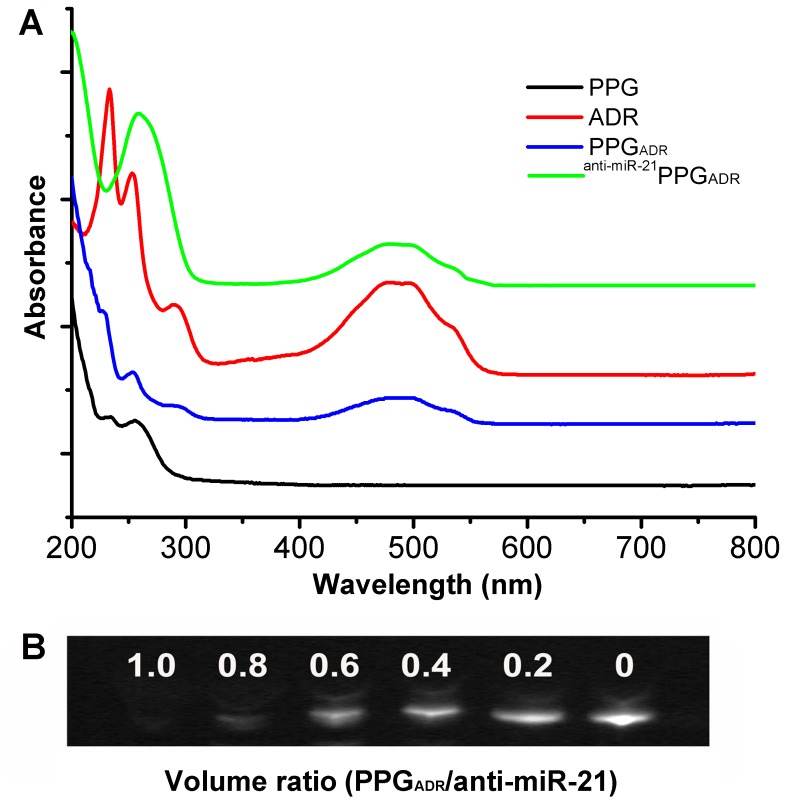
Fabrication of PPGADR, anti-miR-21PPG and anti-miR-21PPGADR.(A) UV-Vis spectra of ADR, PPG, PPGADR and anti-miR-21PPGADR in aqueous solution; (B) Electrophoretic mobility of anti-miR-21 with PPGADR at different volume ratios.